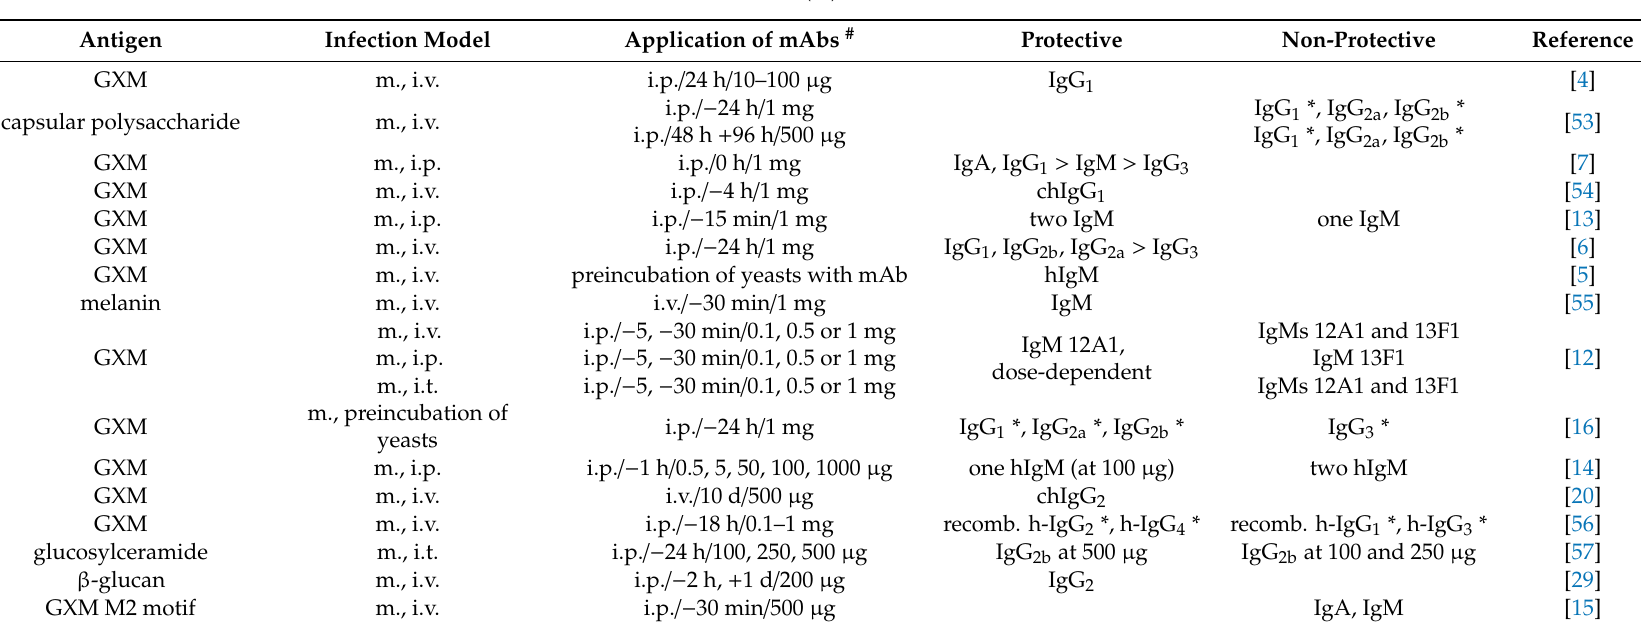
Table 1. ( A ) Protective and non-protective mAbs against Cryptococcus neoformans . ( B ) Protective and non-protective mAbs against Candida albicans . ( C ) Protective and non-protective mAbs against dimorphic fungi. ( D ) Protective and non-protective mAbs against